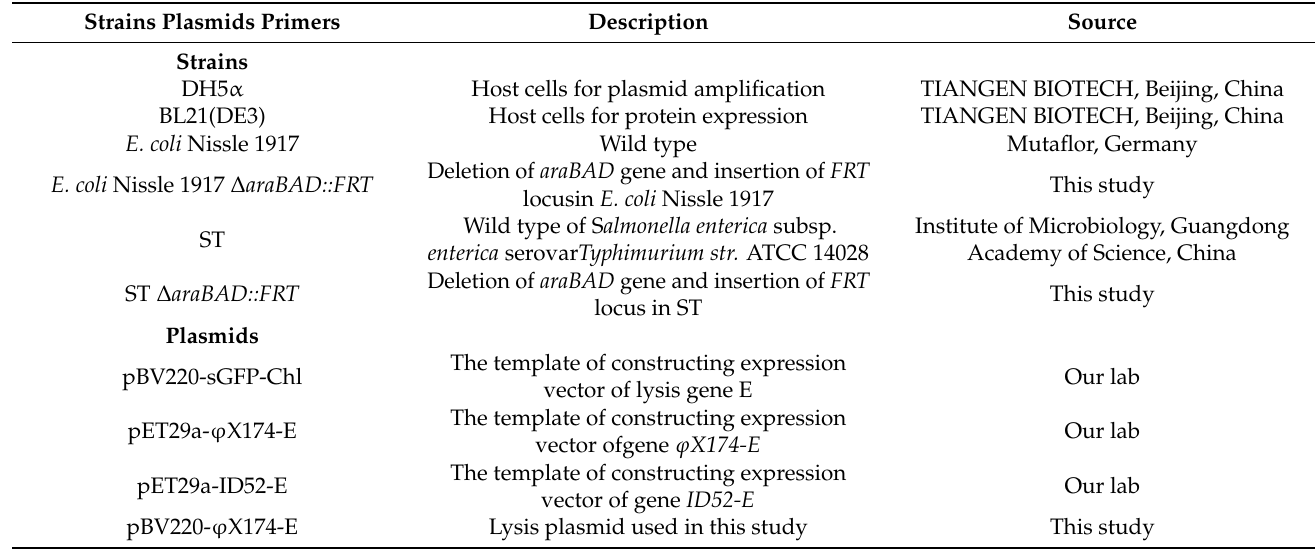
Table 1. Bacterial strains, plasmids and primers used in this